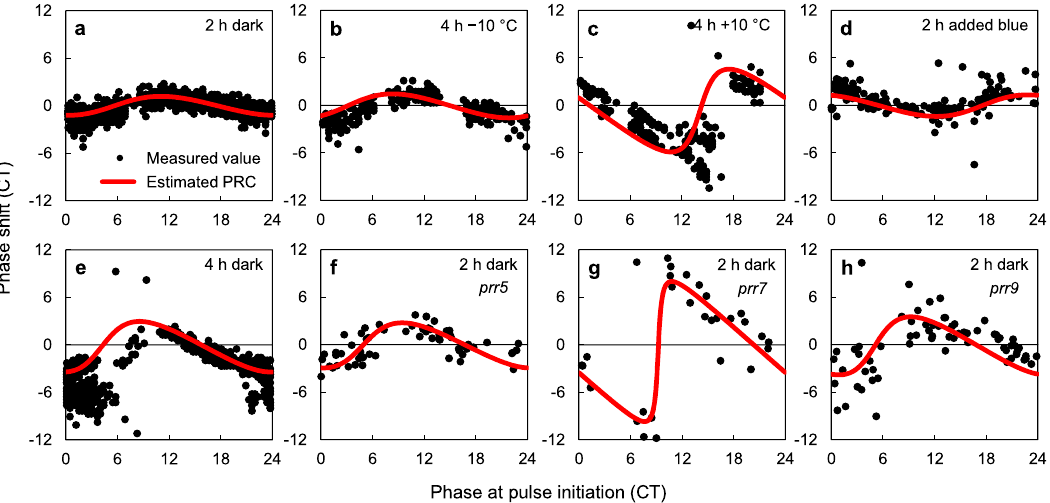
Fig. 2 Construction of PRC from SR. a – e PRCs for 2-h dark ( a ), 4-h 10 °C cooling ( b ), 4-h 10 °C heating ( c ), additional 2-h blue-light ( d ), and 4-h dark ( e ) stimuli measured for CCA1 :: LUC plant. f – h PRCs for 2-h darkness in clock mutants ( prr5 ( f ), prr7 ( g ), and prr9 ( h )) in CCA1 :: LUC . Red lines are PRCs constructed from the